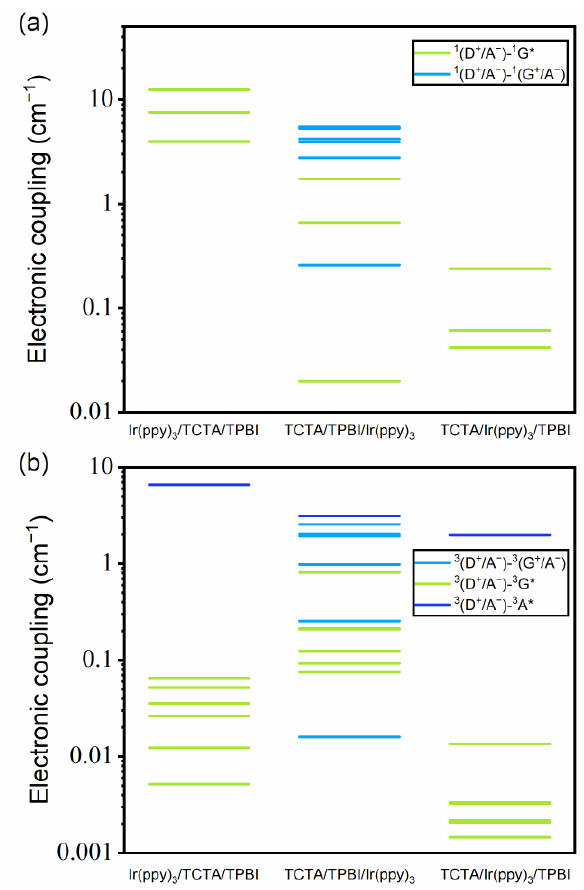
Figure 7. Pictorial representations of the electronic couplings ( a ) between the lowest 1 (D + /A − ) state and other singlet excited states, and ( b ) between the lowest 3 (D + /A − ) state and other triplet excited states.